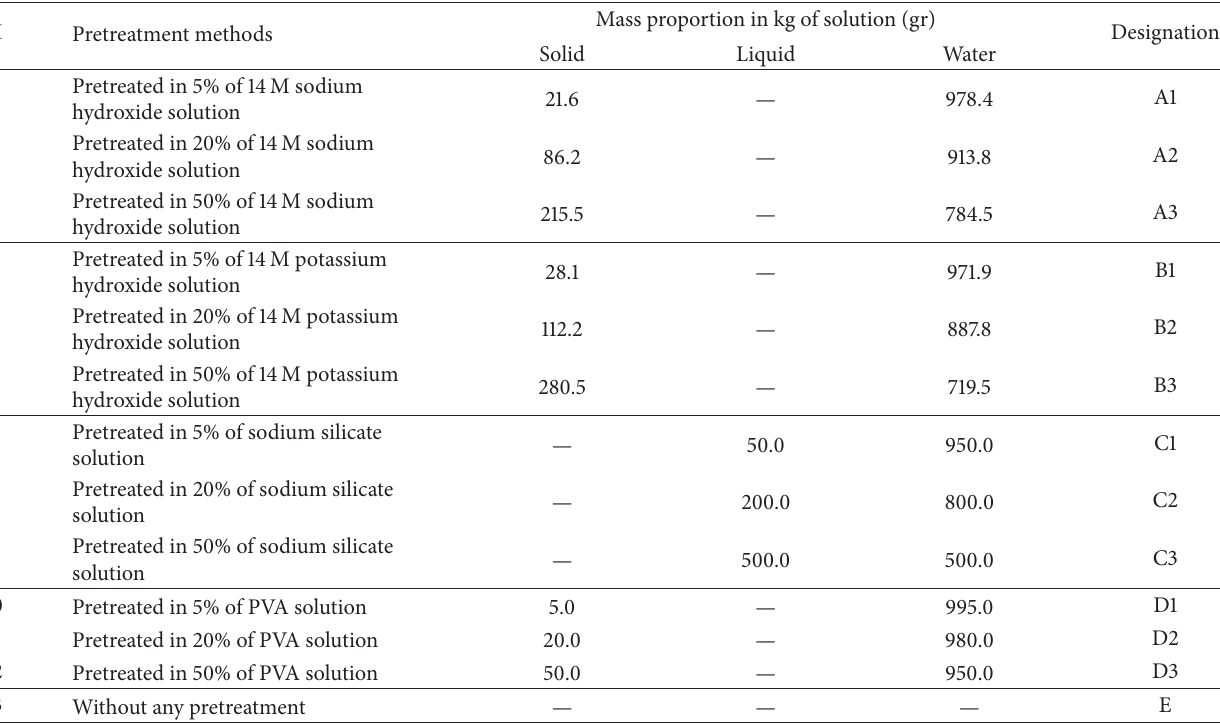
Table 4: Type of chemicals used for pretreatment of OPS aggregates.